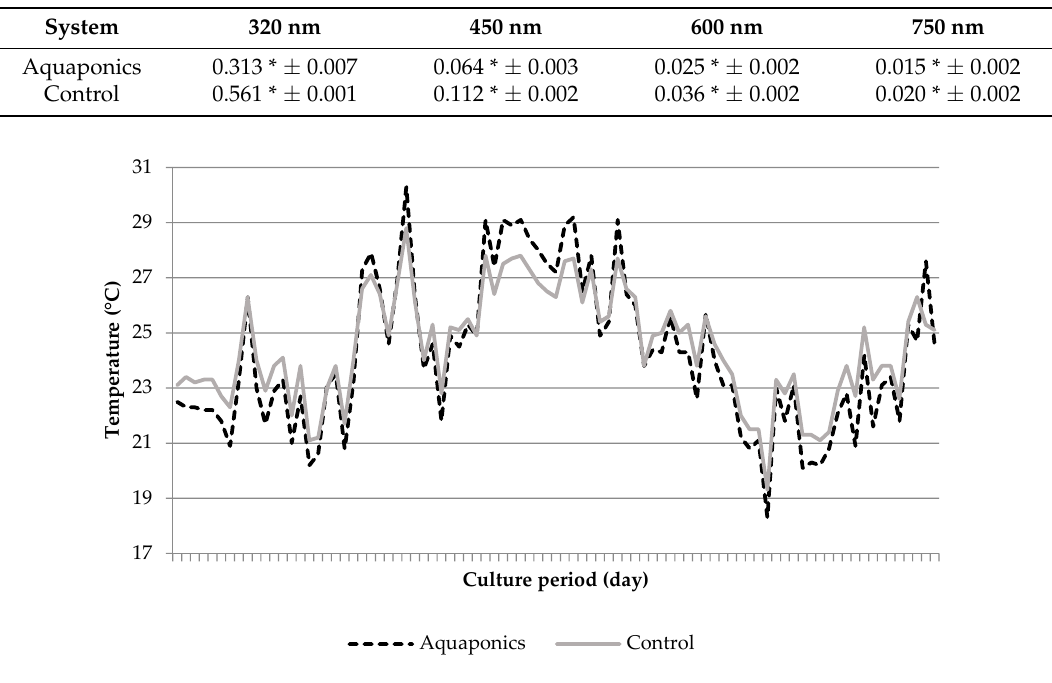
Figure 8. Temporal changes of temperature over the experimental period of 12 weeks.